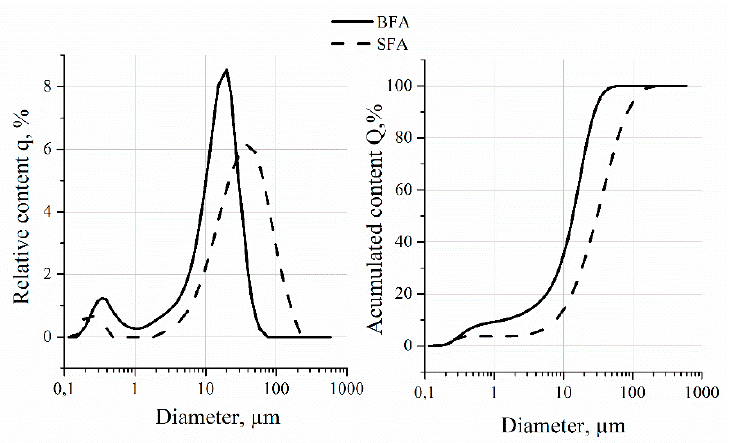
Figure 1. Grain size distribution relative content ( left ) and accumulated content ( right ). Table 3. Statistical analysis of grain size distribution of the mineral additives.